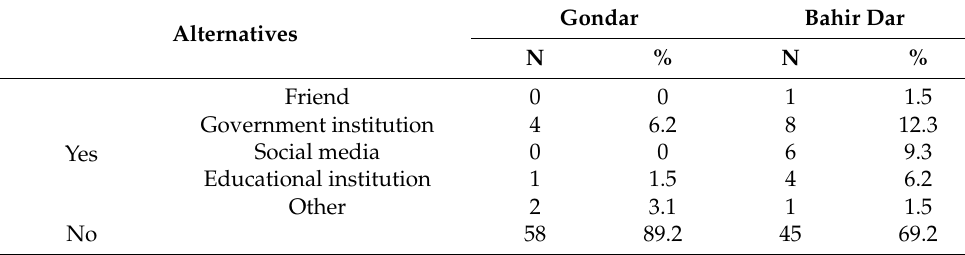
Table 2. Understanding the concept of urban resilience and source of information ( n = 65 in each city).